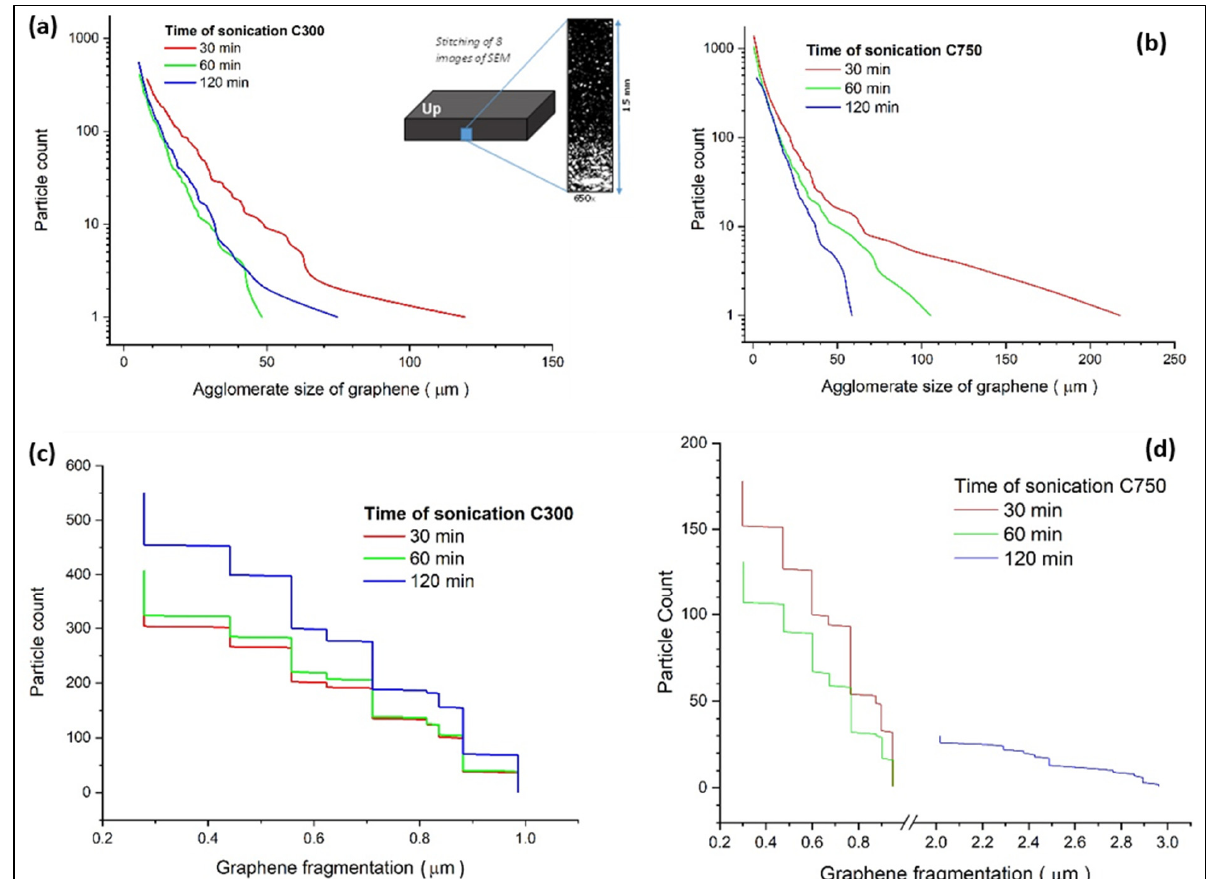
Figure 5. Analysis of agglomerate size and fragmentation state for different dispersion times and graphene types (C300 and C750). Agglomerate size evolution with sonication time for GNP C300 ( a ), and for GNP C750 ( b ), scheme of analysis location, and GNP size evolution for GNP C300 ( c ), and for GNP C750 ( d ).